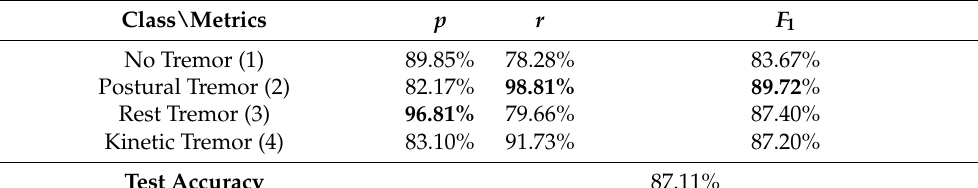
Table 8. Classification performance results computed on acceleration and gyroscope data: in the